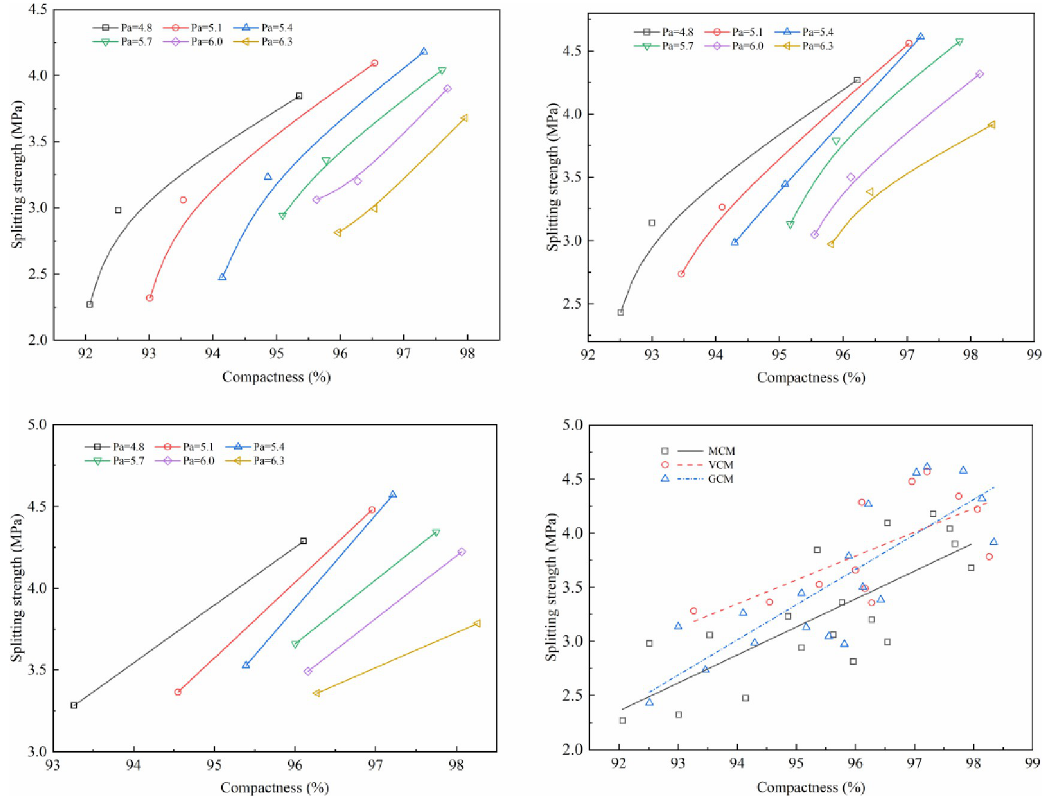
Fig 14. The relationship between splitting strength and compactness. (a) Splitting strength versus compactness under MCM (b) Splitting strength versus compactness under GCM. (c)Splitting strength versus compactness under VCM (d) Relationship between splitting strength and compactness.